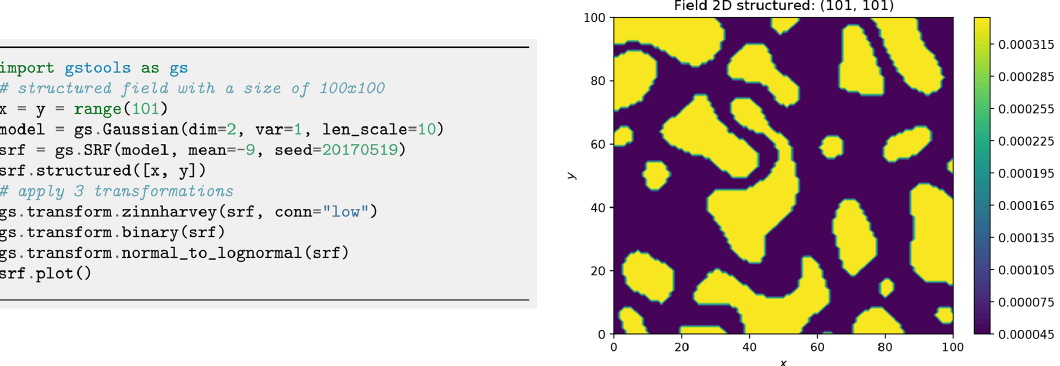
Fig. 11. Field generation is performed through the